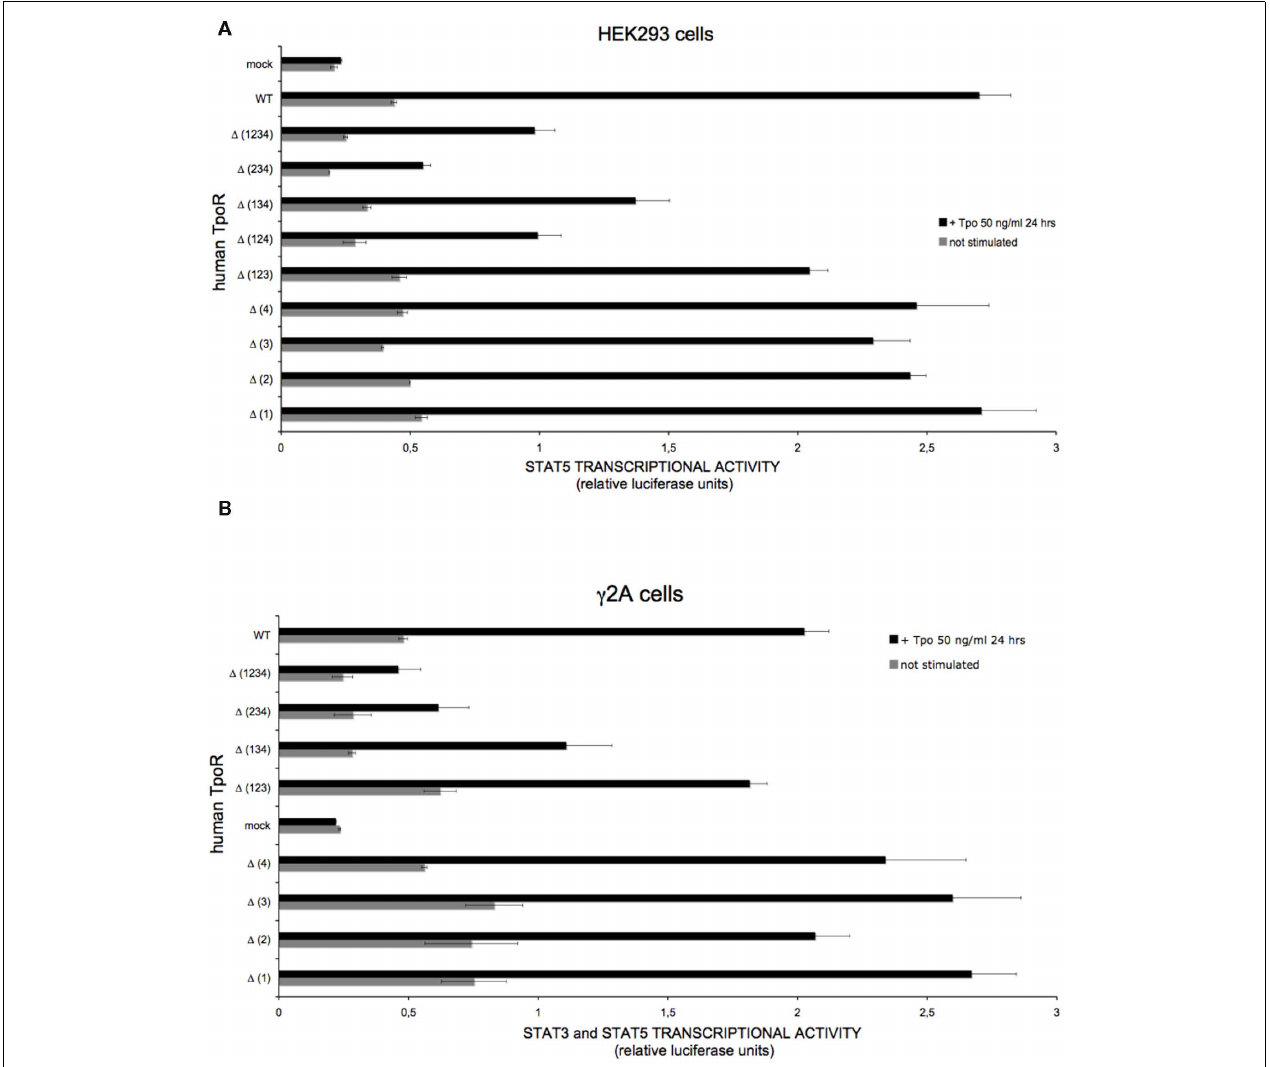
unstimulated condition is significantly different from the stimulated condition for the Δ (1234)TpoR ( p = 0.0058). (B) , JAK2-deficient γ 2A cells were plated in 24-well plates a day before transfection.The cells were co-transfected with plasmids encoding for each of theTpoR variants, the pGRR5-luc and pRLTK-luc reporters, and JAK2WT. Four hours post-transfection cells were stimulated or left unstimulated. Cells were lysed 24h after treatment in 100 μ l 1 × passive lysis buffer and luminescence values were recorded.The experiment was independently performed two times and the result presented represents ± variation of triplicate